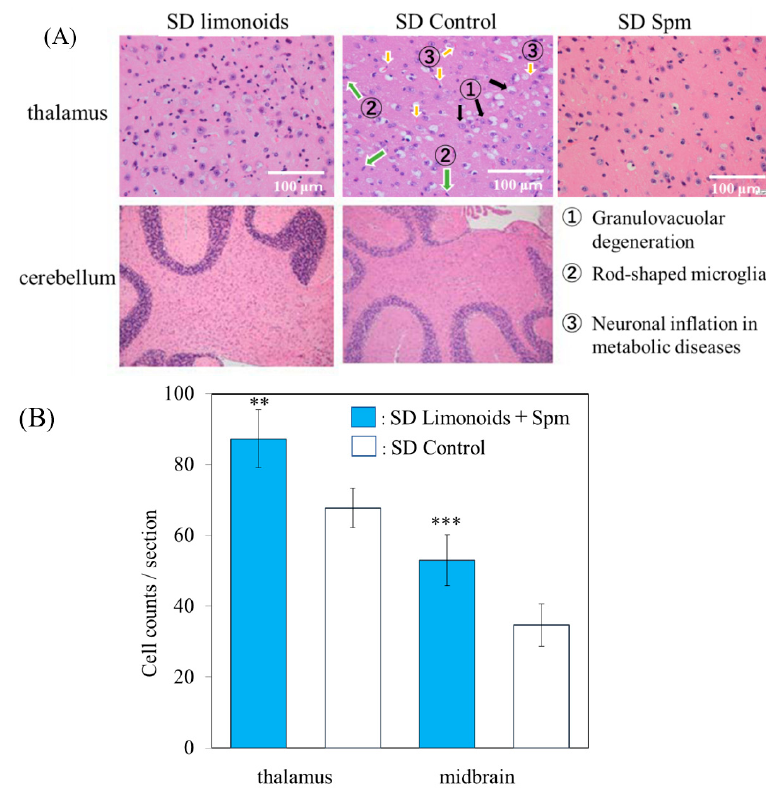
Figure 3. Histopathology of brain tissues for mice with Sandhoff disease (SD) fed with limonoids and Spm. ( A ) H&E staining of thalamic (original magnification: × 400, field size; 0.66 mm 2 ) and cerebellum sections obtained from SD mice fed with limonoids, Spm or a normal diet (SD controls). The sections show enlarged cells with ganglioside storage. ( B ) Number of neurons in the thalamus and midbrain for SD mice fed with limonoids + Spm or control SD mice. Values represent means ± S.D. ( n = 4). Data onto a bar graph are plotted in comparison to the controls for clarity; ** p ≤ 0.01; *** p ≤ 0.001.